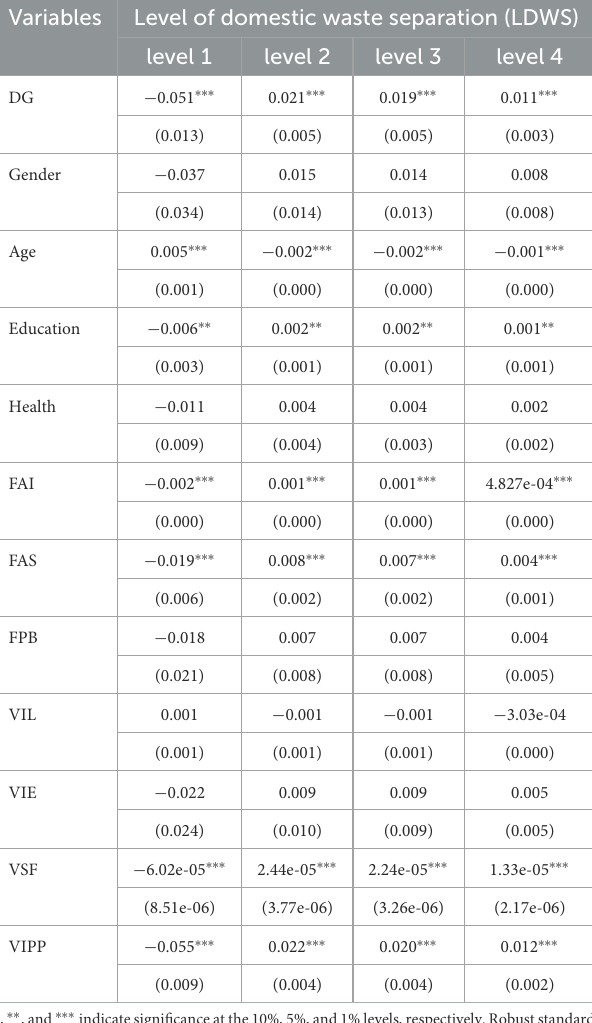
TABLE 4 Marginal effects of the ordered probit model